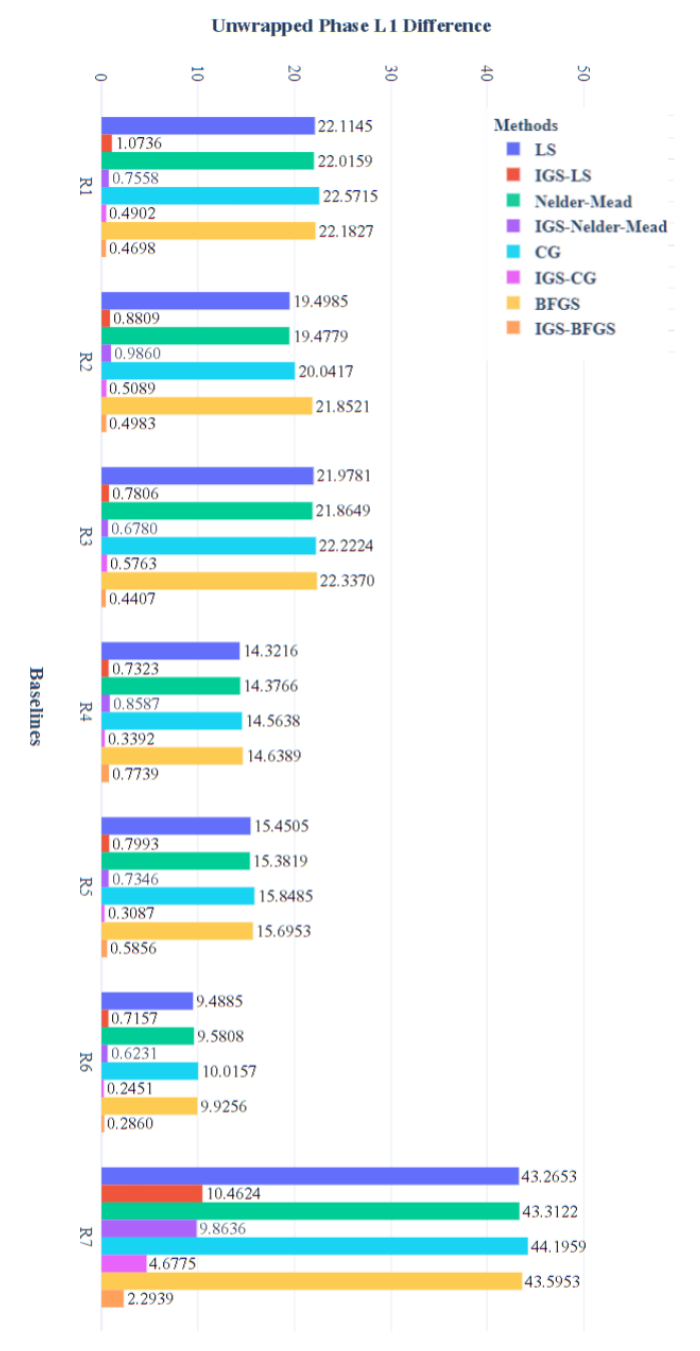
Figure 6. Unwrapped phase L1